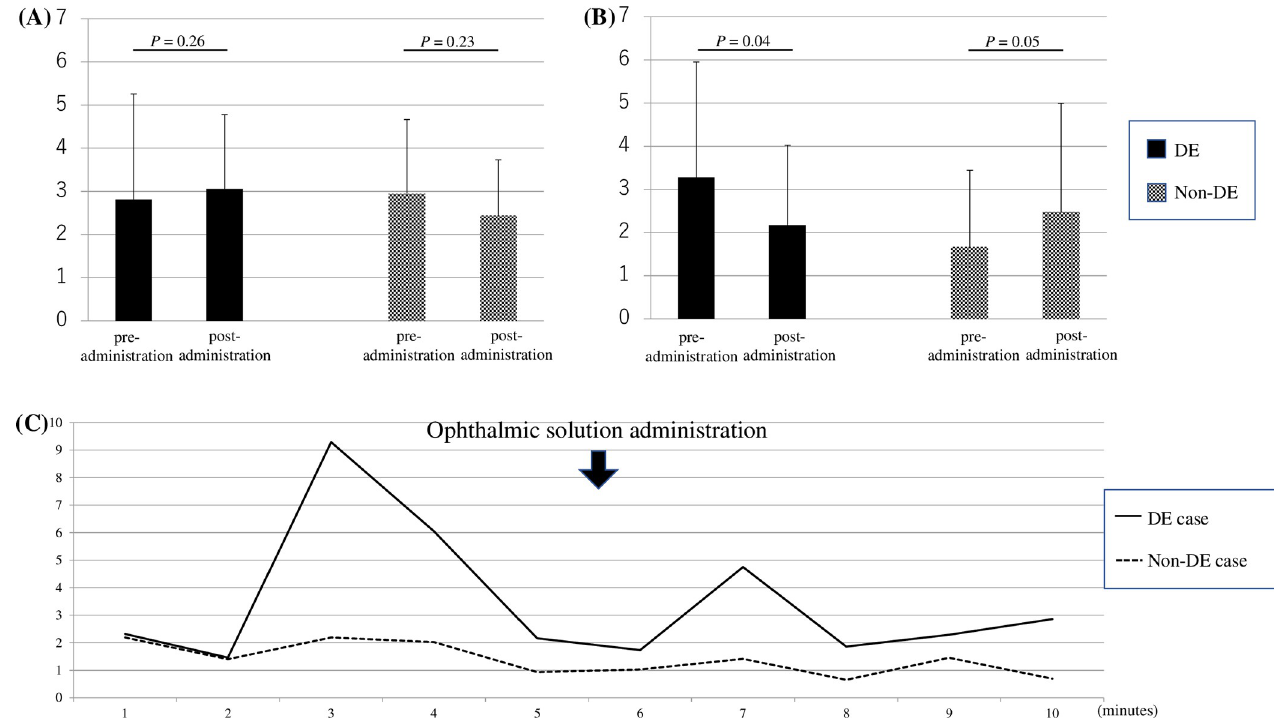
Fig 2. The effect of instilling the ophthalmic solution on the LF/HF ratio and typical cases of fluctuations in the LF/HF ratio over time in the DE and non-DE groups. (A) The LF/HF ratio pre- and post-instillation of ophthalmic solution in the DE and non-DE groups. There are no significant changes in either the DE or non-DE groups (P > 0.05). (B) The standard deviation of the LF/HF ratio pre- and post-instillation of ophthalmic solution in the DE and non- DE groups. The standard deviation of the LF/HF ratio significantly decreased post-instillation in the DE group (P < 0.05), whereas it was low pre-instillation and increased post-instillation in the non-DE group. (C) Typical DE and non-DE cases show fluctuation of the LF/HF ratio over time. The DE case presented is of a 39-year-old woman with a J-OSDI score of 18.8 points. The non-DE case is of a 21-year-old woman with a J-OSDI score of 9.1 points. The fluctuation in the LF/HF ratio of the DE case is larger than of the non-DE case, and it decreases post-instillation. DE, dry eye; HF, high-frequency component; J-OSDI, Japanese version of the Ocular Surface Disease Index Questionnaire; LF, low-frequency component.